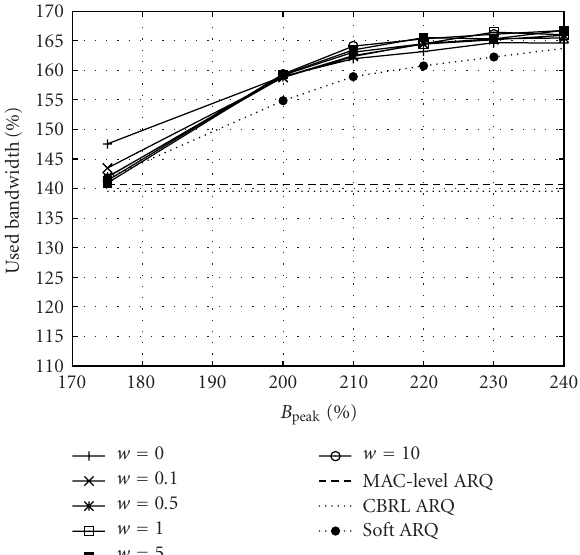
Figure 13: PSNR as a function of the Video #3 bandwidth (varied from 4 to 6 Mbps) for both the MAC-level ARQ and the proposed ARQ scheme; paris sequence. Table 3: Average delay (millisecond) for the standard MAC-level ARQ and the proposed perceptual ARQ